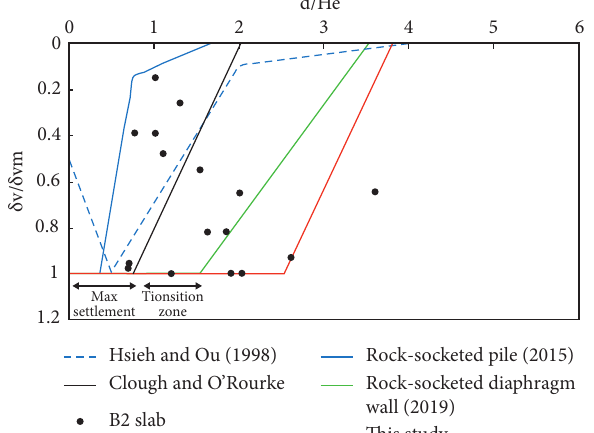
Figure 11: Observed building settlement profiles versus those predicted by empirical methods: the relationship between ( δ ( d / H ) e